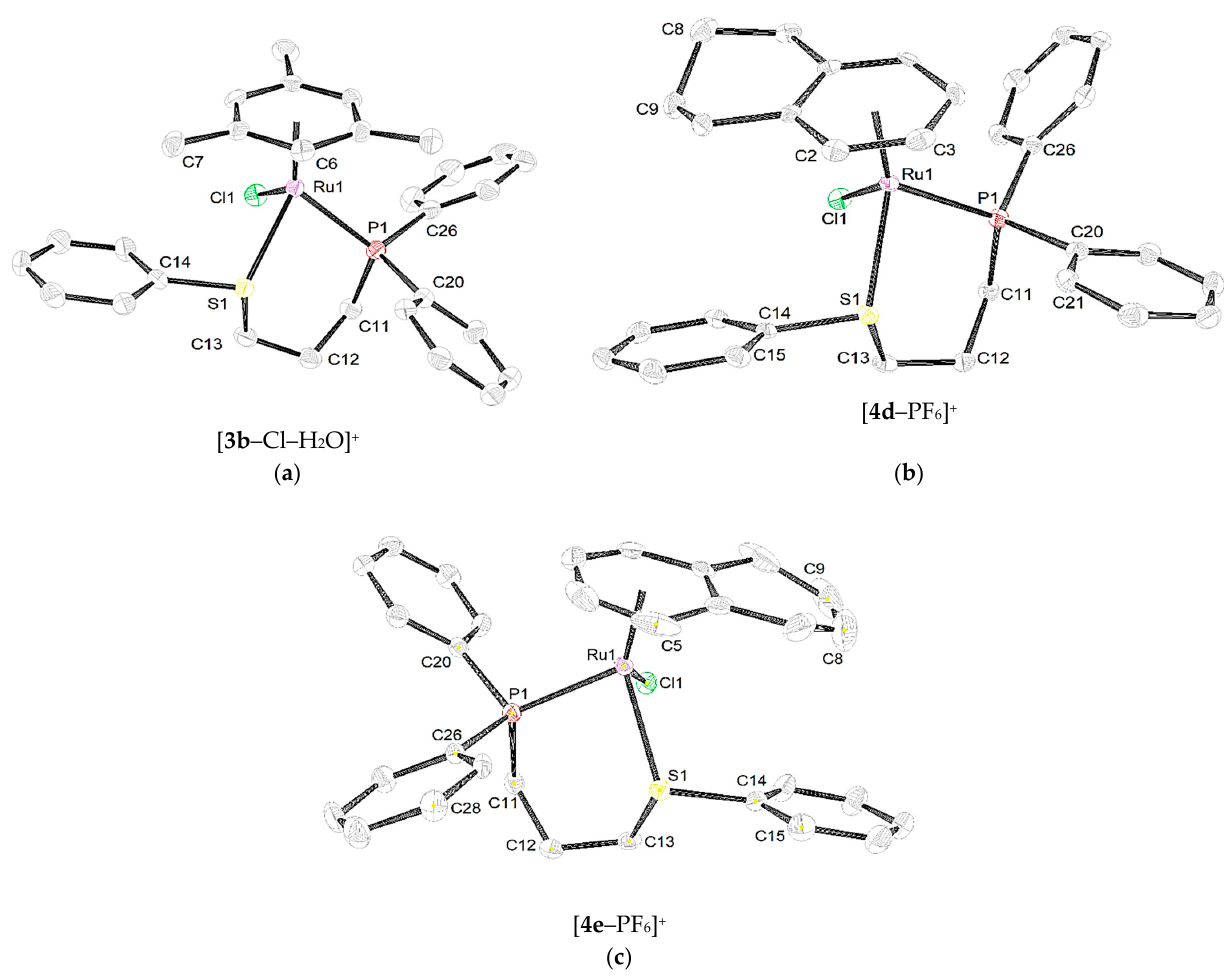
Figure 2. Molecular structure of [Ru( η 6 -arene)Cl{Ph 2 P(CH 2 ) 3 SPh- κ P , κ S }]Cl·H 2 O (arene = mesitylene, thn and 1,4-dialin: ( a ) 3b , ( b ) 4d , and ( c ) 4e , respectively). For 4e only one independent cation is displayed. The ellipsoids are shown with a probability of 50%. H atoms have been omitted for clarity.